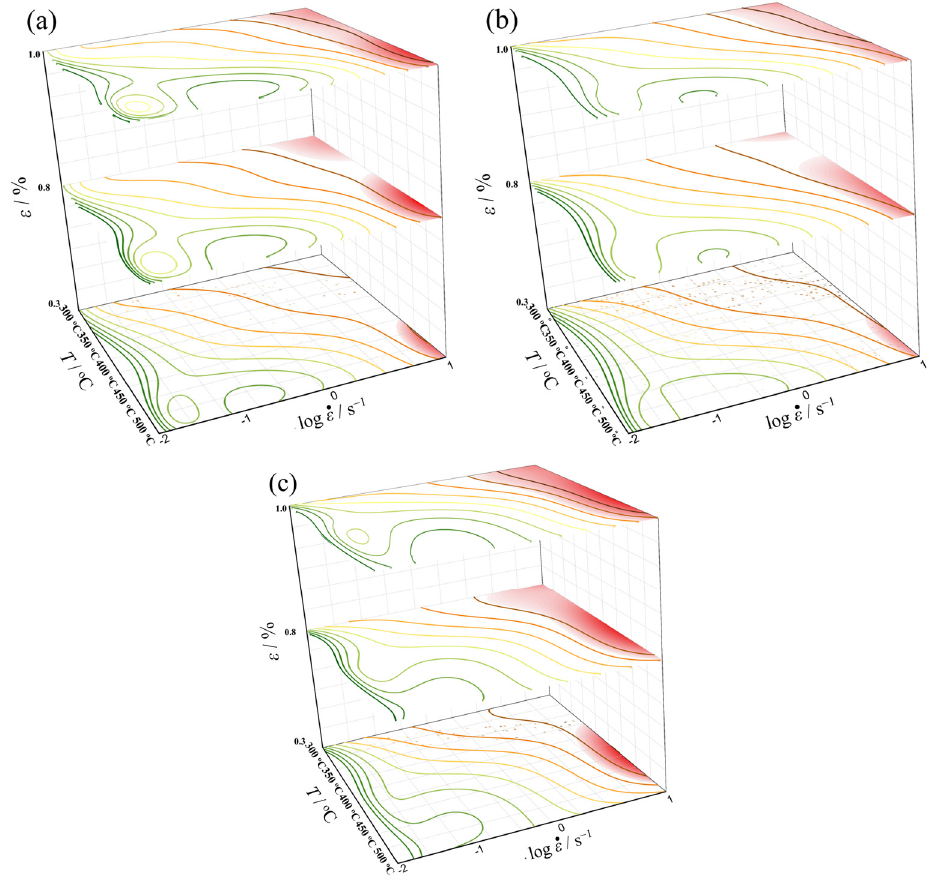
Figure 7. Processing map under different strains of ( a ) AA5182, ( b ) AA5182 − 0.05Sc − 0.1Zr, and ( c ) AA5182 − 0.1Sc − 0.1Zr.